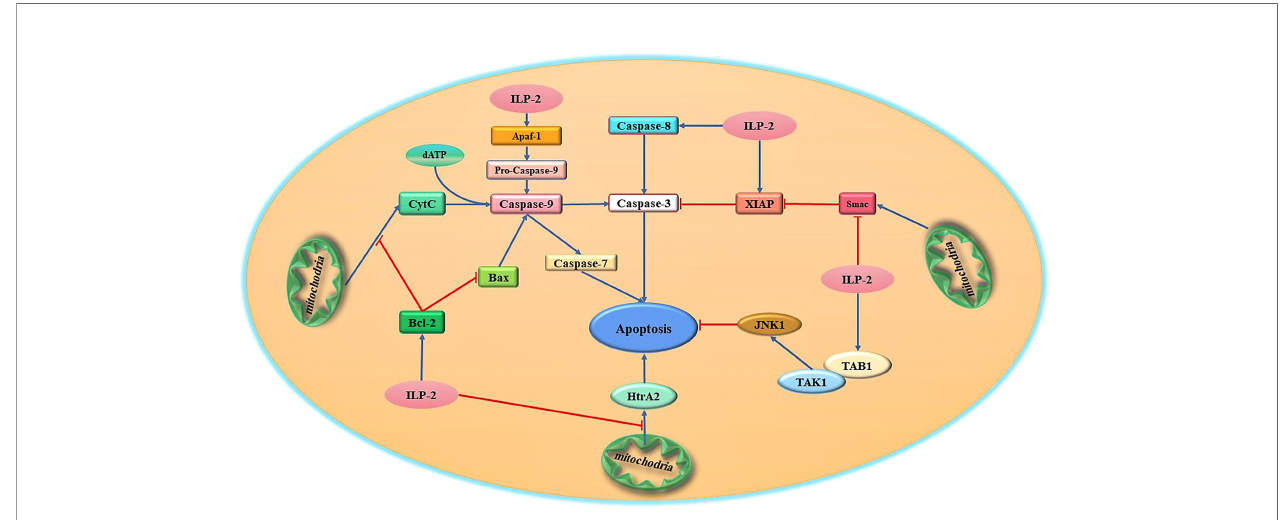
FIGURE 3 | Schematic diagram of the major apoptotic signaling pathways related to ILP-2. ILP-2, which is highly expressed in tumor cells, is one of the high-risk factors for tumor discovery and development, and can activate multiple apoptosis-inhibiting signaling pathways and regulate the expression and activity of various apoptosis-related proteins to inhibit